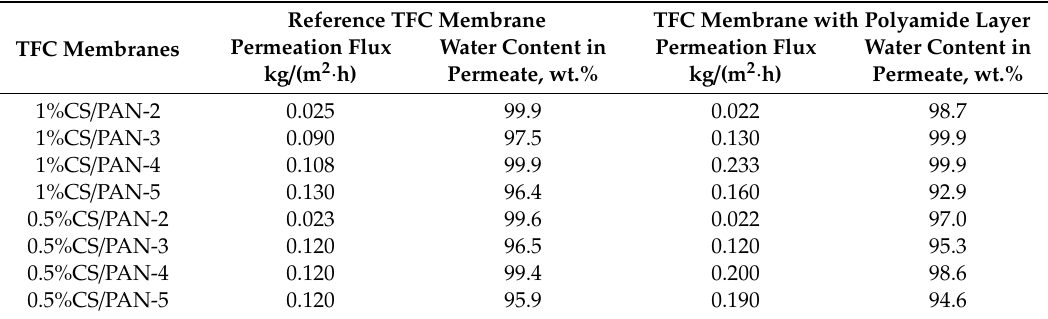
Table 5. Transport characteristics of TFC CS-based membranes with and without polyamide layer formed by IP in separation of azeotropic isopropanol / water (88 / 12 wt.%) mixture. The mean accuracy was < ± 1% for water content in permeate and < ± 8% for permeation